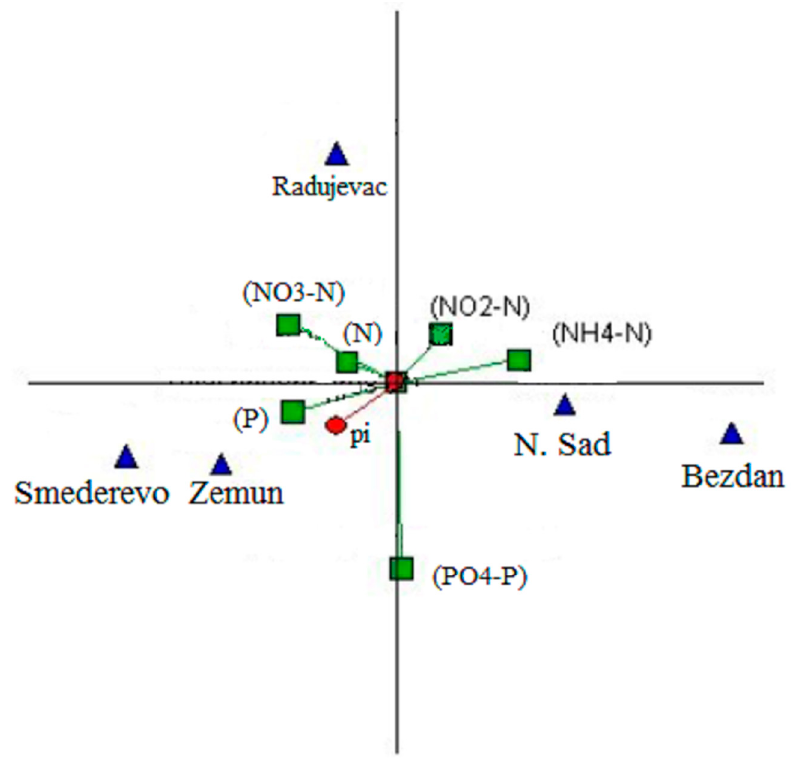
Figure 2. GAIA plot supporting the analysis ( ∆ =